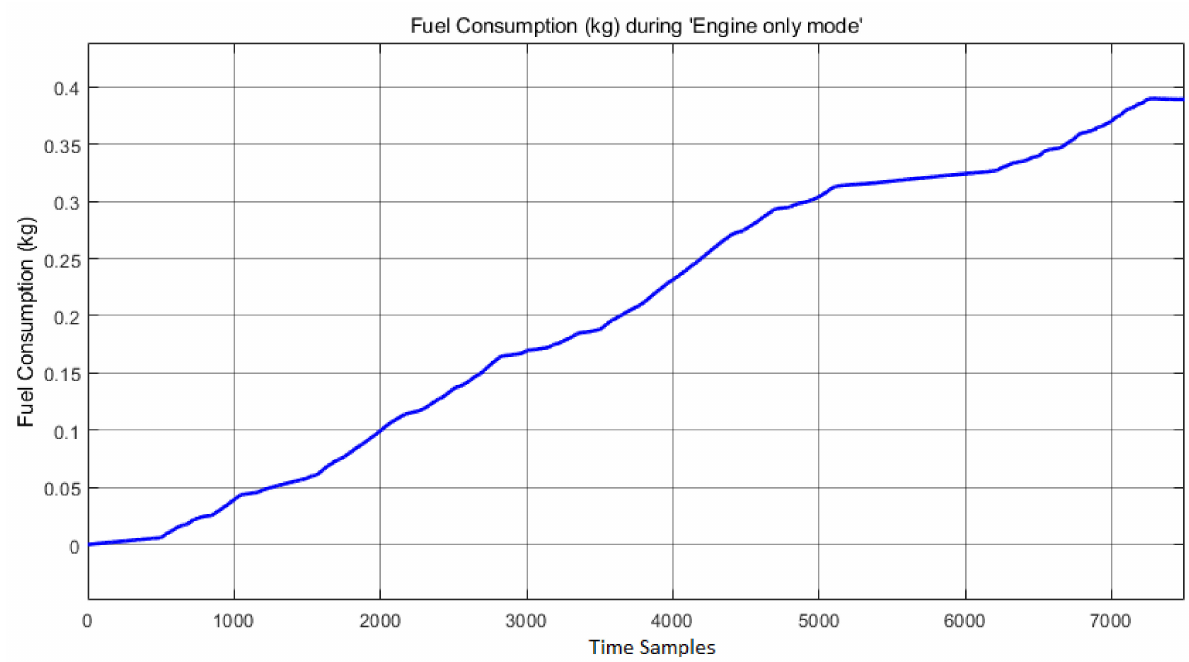
Figure 14. Simulation results for cumulative Fuel consumption during Engine